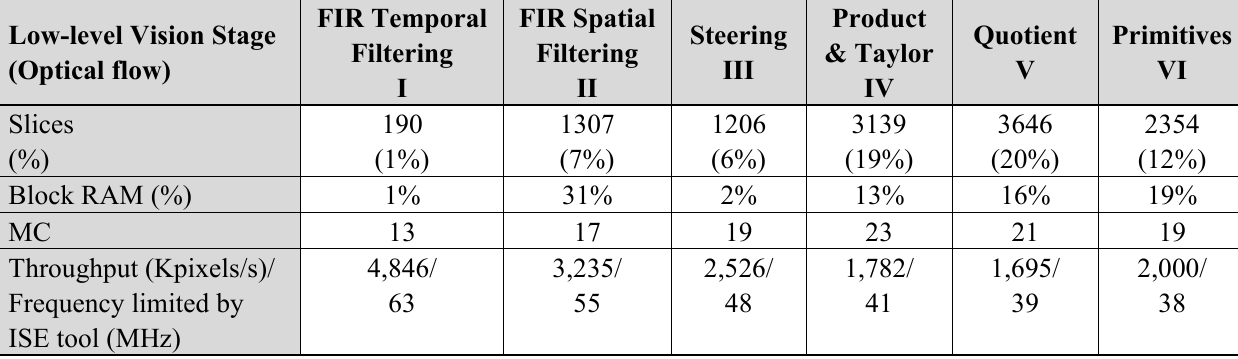
Table 1. Slices, memory requirements, number of cycles and performance for the implementation of Low-level vision. Optical flow scheme.